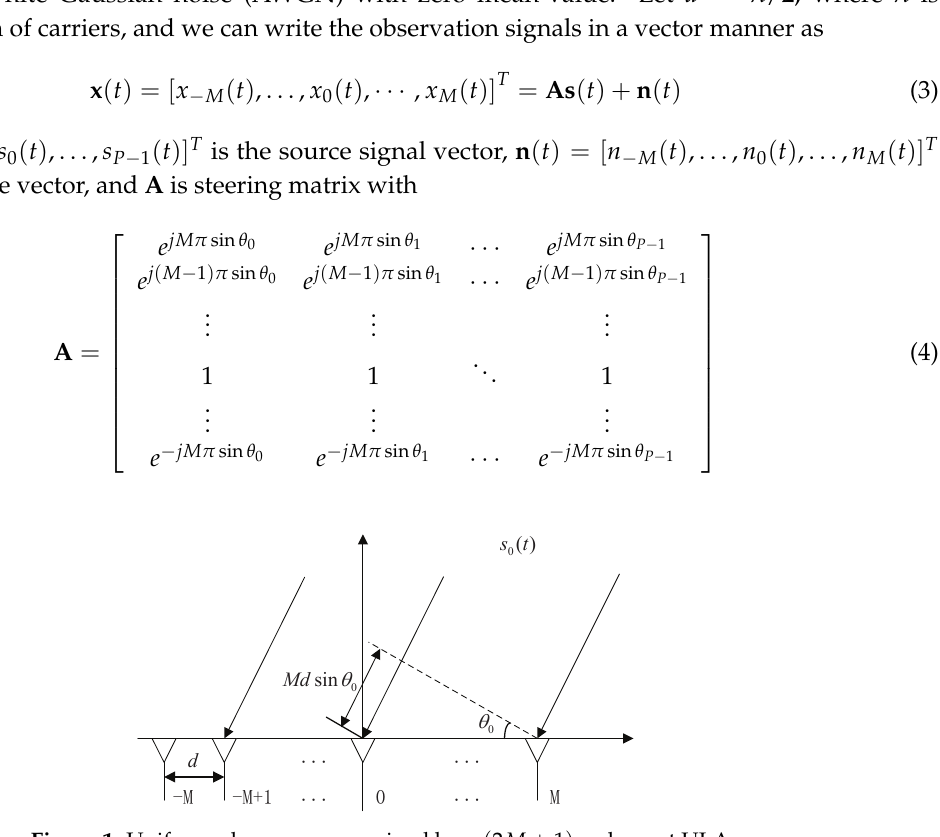
Figure 1. Uniform plane waves received by a ( 2 M + 1 ) —element